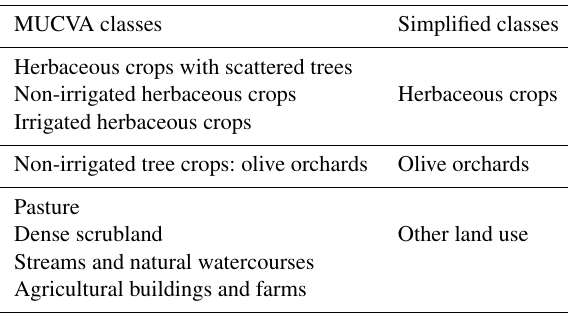
Table 2. Correspondences of the simplified land use classes adopted in this study with the Map of the Land Use and Vegetation Cover of Andalusia (MUCVA, REDIAM).